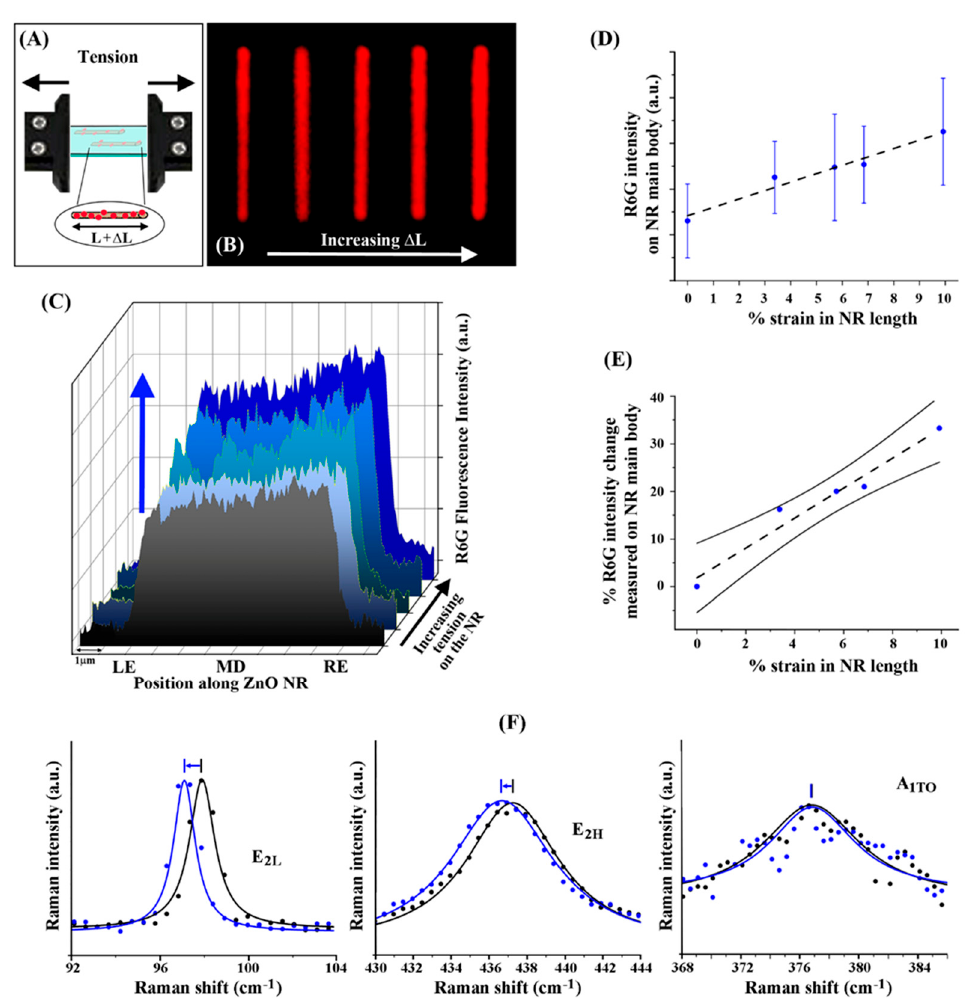
Figure 4. Representative R6G fluorescence intensity along individual ZnO NRs linearly increasing with the addition of incremental tensile strain. ( A ) The schematic shows varying levels of uniaxial tensile strain being applied to R6G/ZnO NRs embedded in a PDMS matrix. The resulting NR length is depicted as L + ∆ L, where L is the length of the ZnO NR at rest and ∆ L is the change in length due to the tensile strain. ( B ) The compiled fluorescence panel qualitatively displays increasing intensity from the R6G emission on the ZnO NR with increasing ∆ L, correlating to an increasing overall NR length. ( C ) The waterfall plot shows the R6G fluorescence intensity along the ZnO NR for different levels of applied tension. The left-end, middle, and right-end positions of the ZnO NR are denoted as LE, MD, and RE, respectively. The grey graph in the front shows the R6G fluorescence intensity under the neutral state. The graphs cascading towards the back are from the cases of increasing tension on the NR. The increase in fluorescence intensity with increasing tensile strain is highlighted with the blue arrow. ( D ) The plot displays R6G intensity on the NR against the % strain in its length under tension. The R6G fluorescence intensities along the NR at rest and increasing tensile states are plotted at 0 and higher positive values of % strain. The error bars denote the standard deviation of all 115 ZnO NRs studied under tension. ( E ) The plot shows the % R6G intensity change measured on the NR versus the % strain in NR length under tensile strain. The solid black lines above and below the data points indicate the 95% confidence interval. As a visual guide, the dashed lines in ( D , E ) are linear fits for the data points. ( F ) Raman spectra for the phonon modes of E 2H , E 2L , and A 1TO were collected from a clean ZnO NR embedded in PDMS under no stress and subsequently under tensile strain. The strain-free and tension data are shown in black and blue, respectively. The E 2H and E 2L peak shifts to a lower energy confirms that our NRs in this portion of the study sustained uniaxial tension as